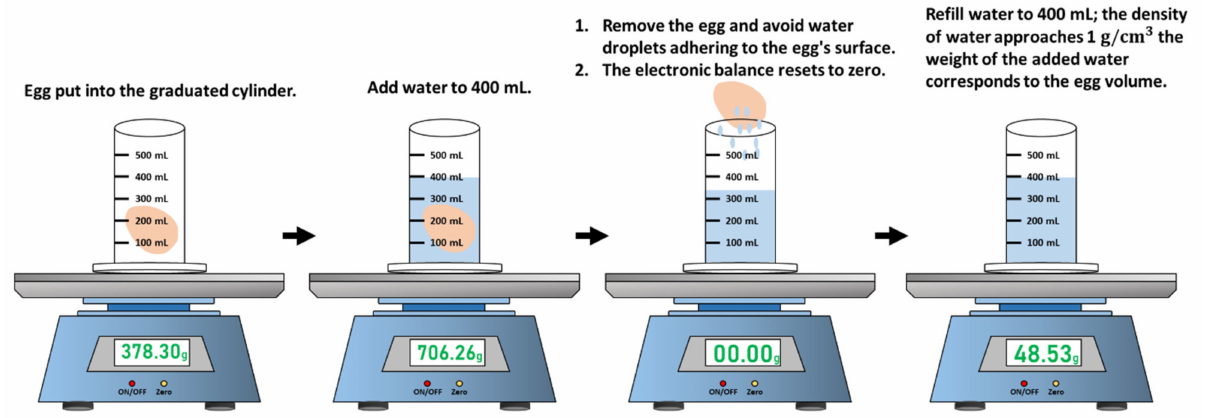
Figure 1. Flow chart of egg volume measurement.